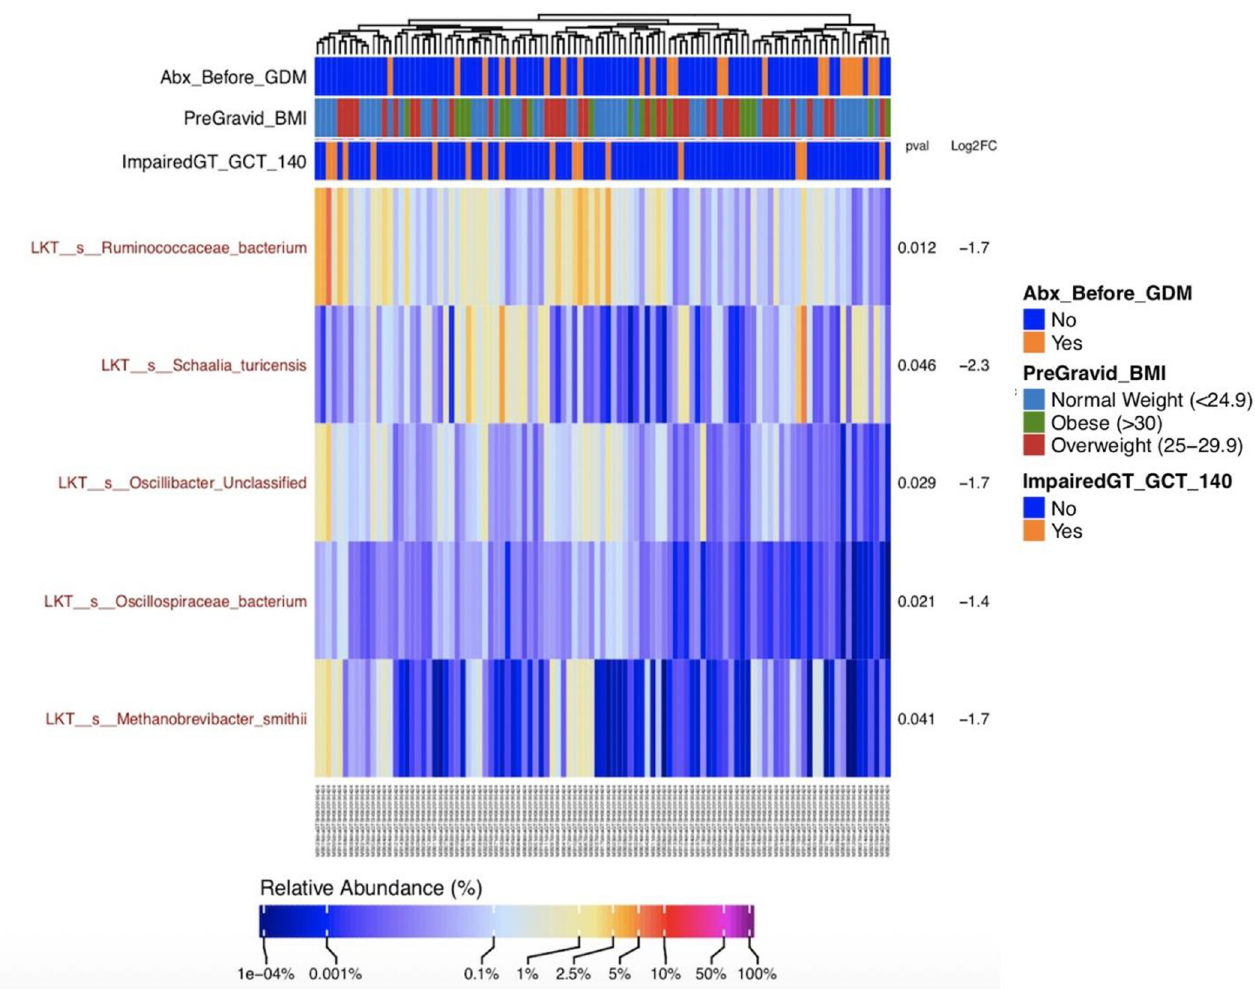
Fig 1. A relative abundance heatmap of last known taxa comparison between individuals with impaired and normal glucose tolerance on the glucose challenge test. Features included in this heatmap had to be present in at least 10% of biospecimens at a level of greater than 500 parts per million with a genome completeness sequencing greater than 0.1. Vertical columns represent each biospecimen included in the analysis (n = 105). Corresponding colors on the top three horizontal rows reflected clinical metadata described in the legend.